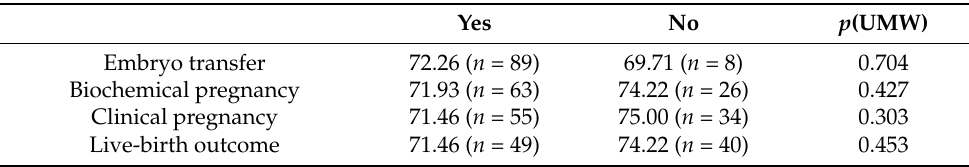
Table 4. Association of sperm PRR levels with reproductive